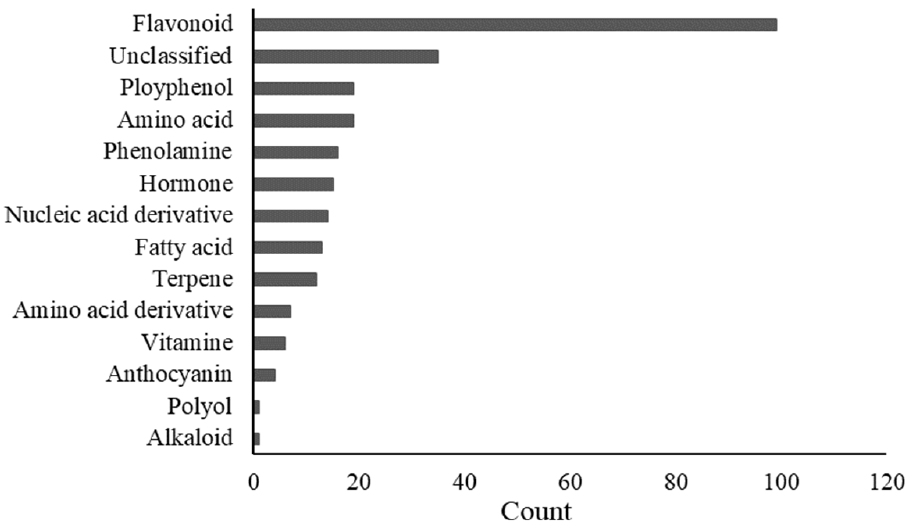
Figure 8. Classification of identified 261 metabolites.